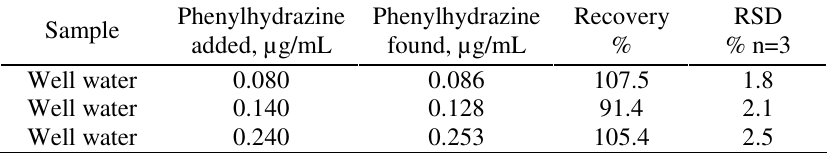
Table 3. Determination of phenylhydrazine in real samples